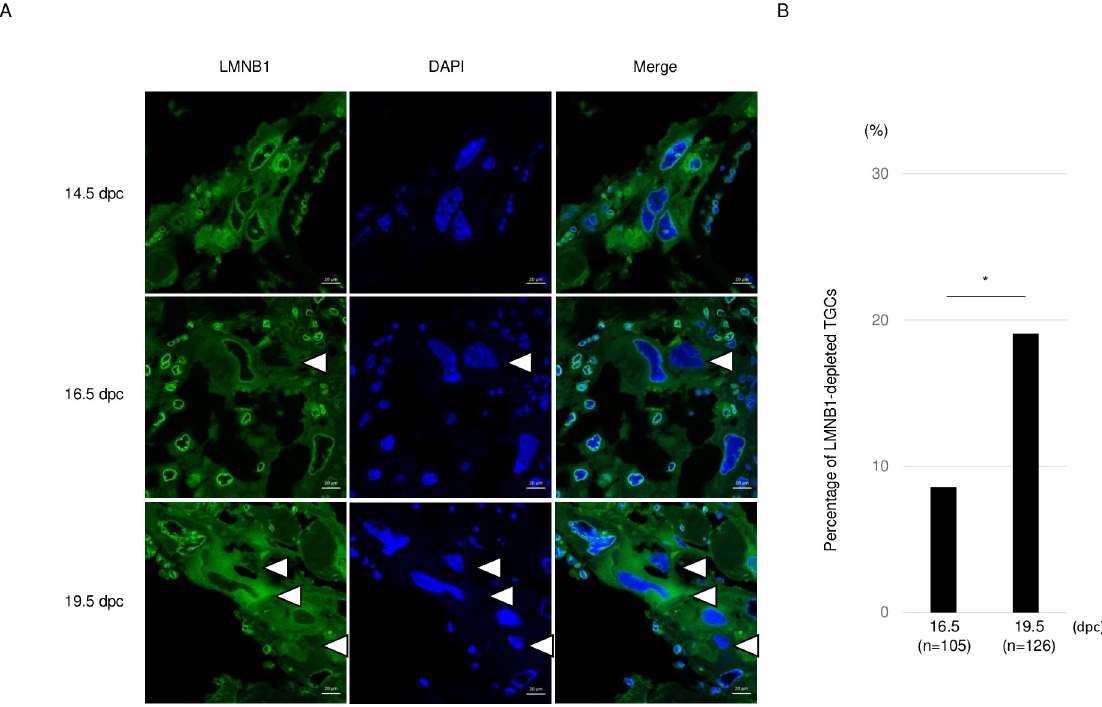
Fig 5. LMNB1 expression in placenta at 14.5, 16.5, and 19.5 dpc. (A) White arrowheads indicate LMNB1-depleted TGCs. LMNB1-depleted TGCs were detected at 16.5 and 19.5 dpc. (B) Percentage of LMNB1-depleted TGCs. Statistical analysis was performed by the χ 2 test:16.5 dpc (n = 105) and 19.5 dpc (n = 128). � , P <